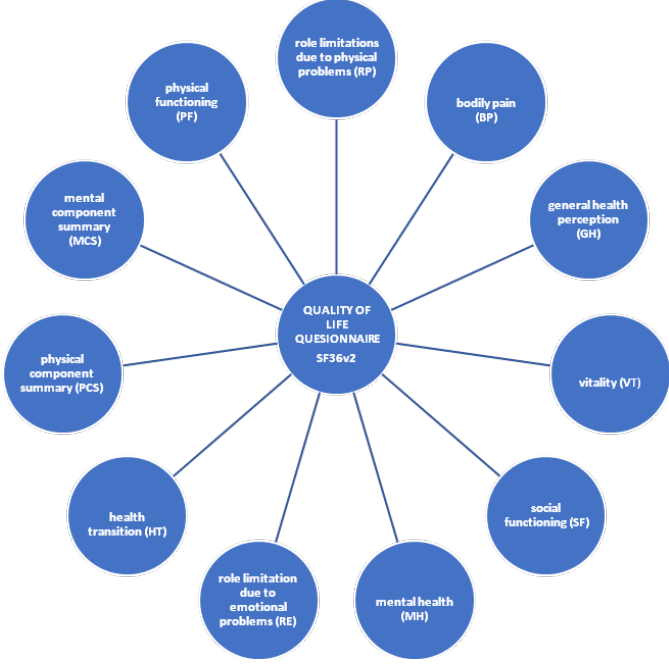
Figure 1. Dimensions used to assess the quality of life in SF36v2 questionnaire.Source: authors’ own